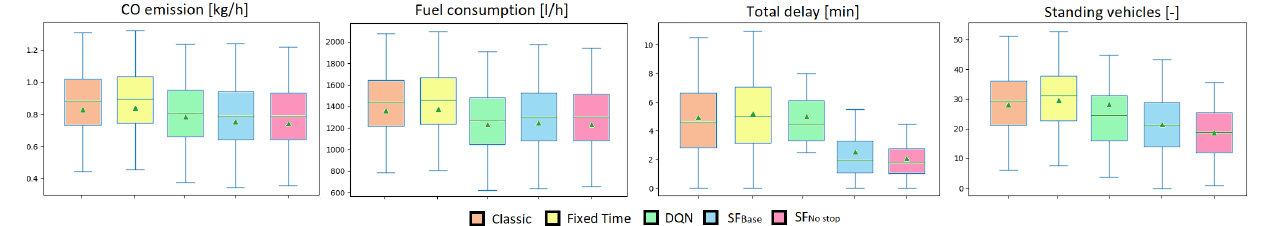
Figure 1. Comparison of classic (orange), fixed-time (yellow), DQN (green), and SF-based approaches (blue and magenta). Each boxplot refers to the average values and their distribution based on 1000 randomized scenarios with uniform flow. The compared metrics are the average of CO emis- sions, fuel consumption, total delay, and standing vehicles. The SF-based agent preferences are w base = [ 1,1,1,1,1 ] and w nostop = [ 0,0,0,1,0 ] .